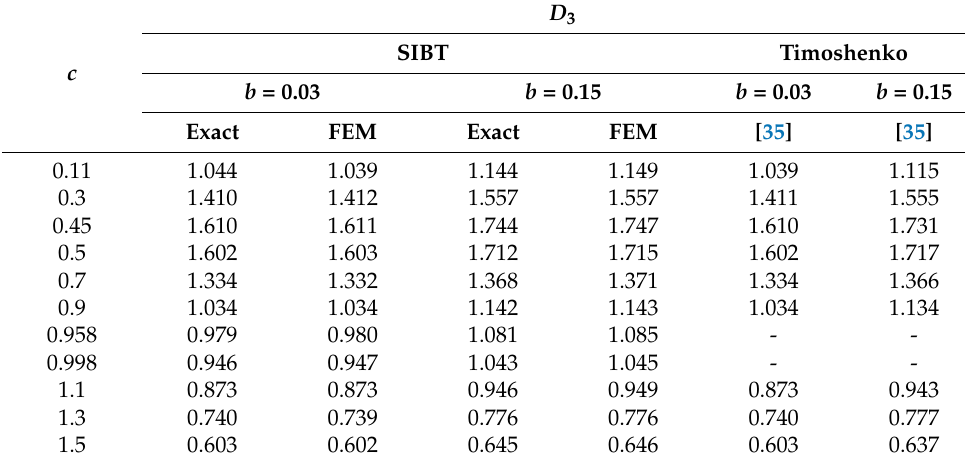
Table 4. D 3 for different cross-section and moving